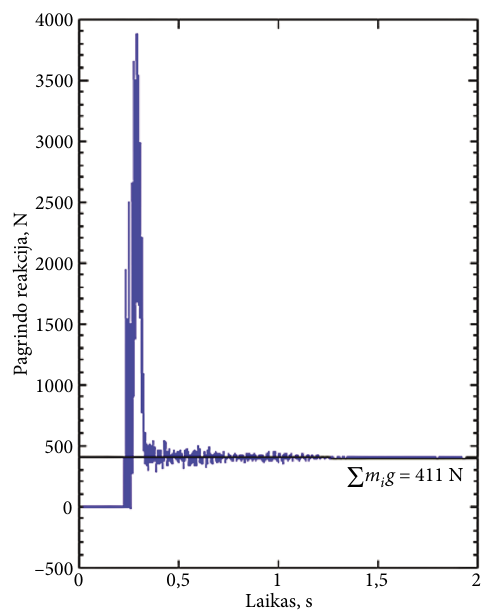
Fig. 6. Reaction balance between the basis of the computational space of the monodispersed mixture and the total weight of particles